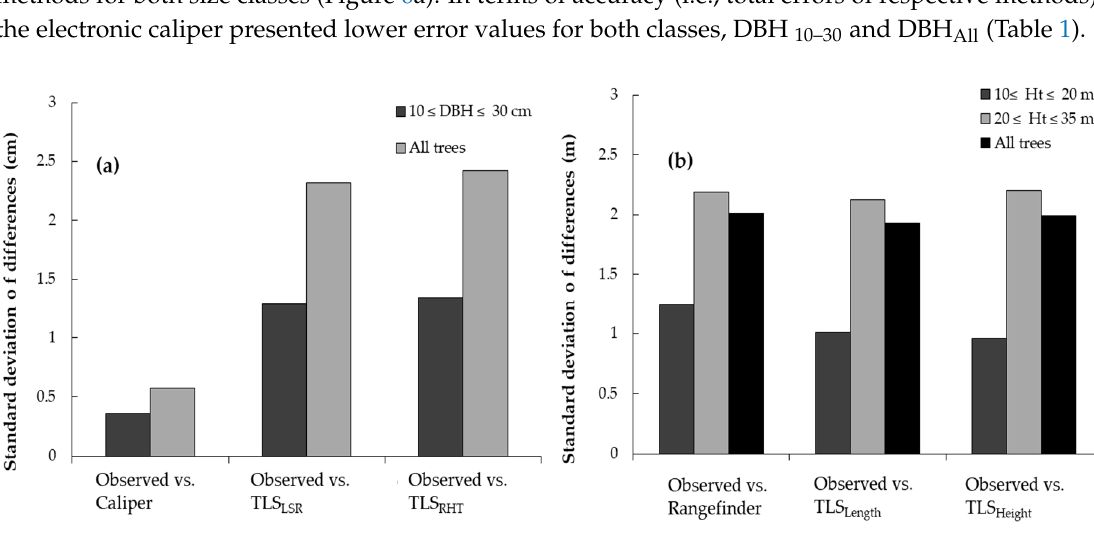
Figure 5. The observed (tape measured) DBHs versus the DBH measured with the caliper from the field map bundle and extracted from the terrestrial laser scanning (TLS) point cloud using two different methods—TLS RHT and TLS LSR —estimated for different tree size classes: DBH 10–30 (upper panel) and DBH All (lower panel): The solid lines represent the adjusted linear models, and the dashed lines represents the 1:1 lines (Y = X).